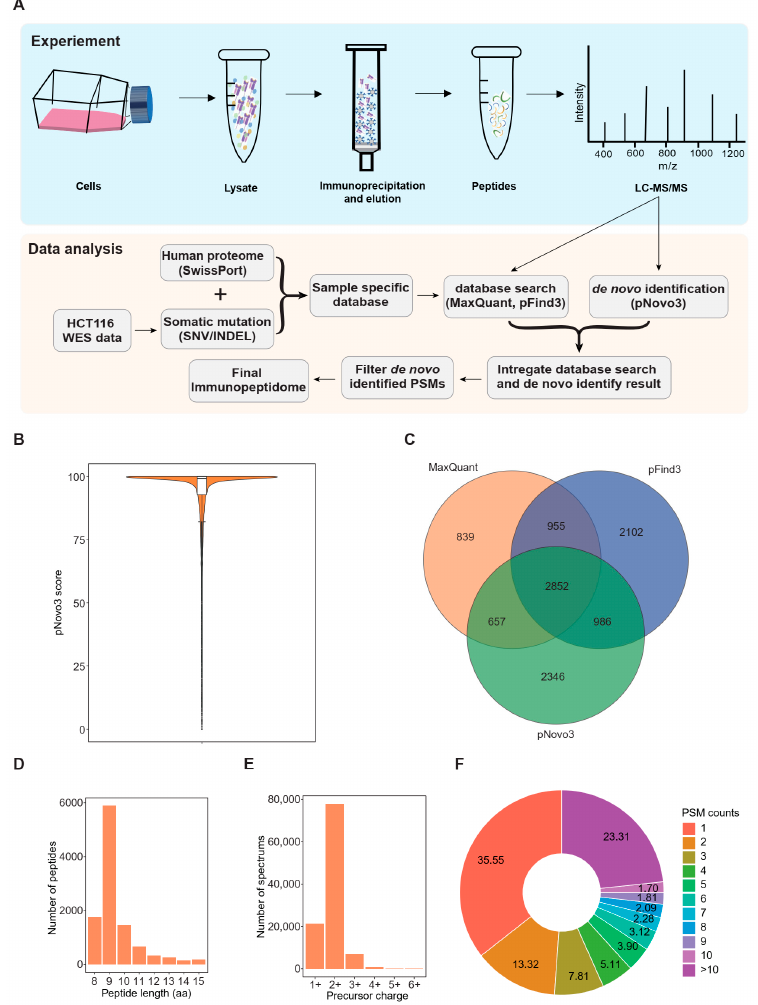
Figure 1. Proteogenomic-based identification of the human leukocyte antigen (HLA) immunopep- tidome: ( A ) Schematic representation of experimental and bioinformatic workflow for HLA-I- presented peptide identification; ( B ) Distribution of peptide-spectrum match (PSM) scores re- ported by pNovo3 for peptides identified by all three items of software; ( C ) Venn diagrams show- ing the reproducibility of HLA-I-presented peptides identified using the three items of software; ( D ) Length distribution of HLA-I-presented peptides; ( E ) Precursor charge distribution of the HCT116 immunopeptidome; and ( F ) Peptide-spectrum match (PSM) count distribution of the HCT116